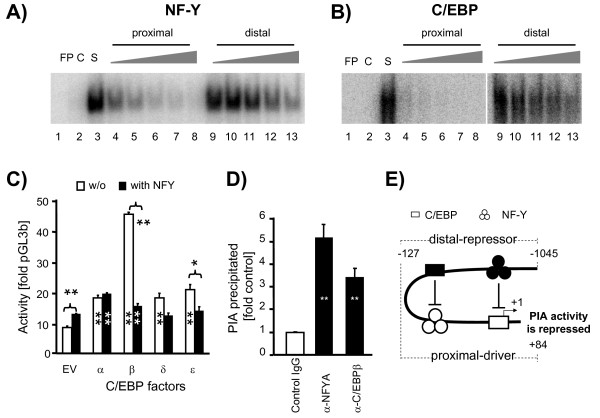
Comparison of the binding affinities of the distal and proximal NF-Y and C/EBP sites and influence of these factors on the PIA activity. (A) Affinity comparison of the proximal and distal NF-Y binding sites of PIA. Nuclear extracts were prepared from HEK293 cells jointly over-expressing the three bovine NF-Y factors (A, B, C). Sequences of the labeled NF-Y consensus probe and of the unlabeled competitor of the distal NF-Y (A_WT) and proximal NF-Y sites (pNF_WT) are shown in Additional file 1: Table S4 cf (Figures 2A and Figure 3A). Lane: FP, free probe; C, competition with 100-fold molar excess of unlabeled probe (self); S, shift. The fold molar excess of the respective unlabeled competitors added to the reactions, as resolved in lanes 4–8 or lanes 9–13 were 10, 25, 50, 100, 200-fold of the labeled probe. (B) Same as A, but evaluating the C/EBP binding sites. These samples were run out on the same gel. Nuclear extracts were prepared from HC-11 cells over-expressing the DNA binding domain of the bovine C/EBPβ factor. Sequences of the labeled C/EBP consensus probe, the unlabeled oligonucleotide competitors of C/EBP distal (C_WT) and C/EBP proximal (pCE_WT) are shown in Additional file 1: Table S4 cf (Figure 2A and Figure 3A). (C) Effects of NF-Y and C/EBPβ factors on the proximal PIA activity. The proximal PIA reporter construct −127 was transfected into HC-11 cells, together with the empty cloning vector (EV) or with constructs expressing C/EBPβ or NF-Y subunits, as indicated. The functional NF-Y trimer can quench this effect. Results (±S.E.M.) are representative for two experiments, each assayed in triplicate. Statistical significance of the differences was calculated relative to the control having been cotransfected only with empty vector (grey column), **P <0.01. (D) NF-Y factors interact with C/EBPβ having bound to PIA. HEK293 cells were co-transfected with the −127 PIA reporter gene and expression constructs for the factors C/EBPβ (tagged with a flag), NF-YAm29, -YB, -YC. Nuclei were used for ChIP assays using antibodies against C/EBPβ or NF-YA or control IgG. Data are mean values (±S.E.M.) of four qPCR assays of the amount of recovered PIA promoter molecules (**P <0.01, as compared to control IgG). (E) A master control unit modulates PIA activity. NF-Y and C/EBP factors (black) having bound to the distal repressive factor binding sites may be looped back to physically contact the respective other factor (open) having bound to the proximal driver region. This interaction lowers PIA activity. The map is not drawn to scale. “+1” represents the tsp.